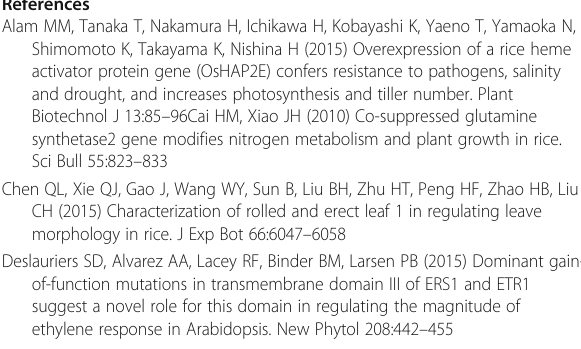
field. Table S3. List of the detailed gene information of the 90 cloned TN variation associated genes. Table S4. The haplotype analysis of the Moc3 gene in the accessions with extreme low and high TN phenotypes. Table S5. The detailed information of the genes located in the 15 novel LATNs. Table S6. The seven candidate genes used for full length sequencing and expression analysis. (XLSX 50 kb)